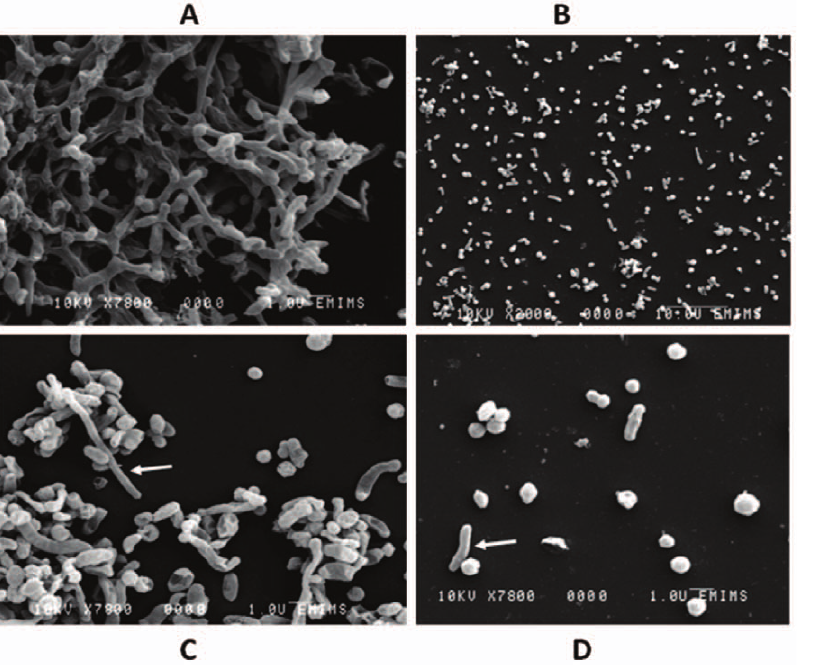
Figure 4. Scanning electron microscopy (SEM) images of S.wadsworthensis showing different morphologies for this organism. Small and large, filamentous and helical bacteria forms were observed. A) S. wadsworthensis cells formed as a lattice B) Different Sutterella cell morphologies C) Filamentous bacterial form D) Helical bacterial form.